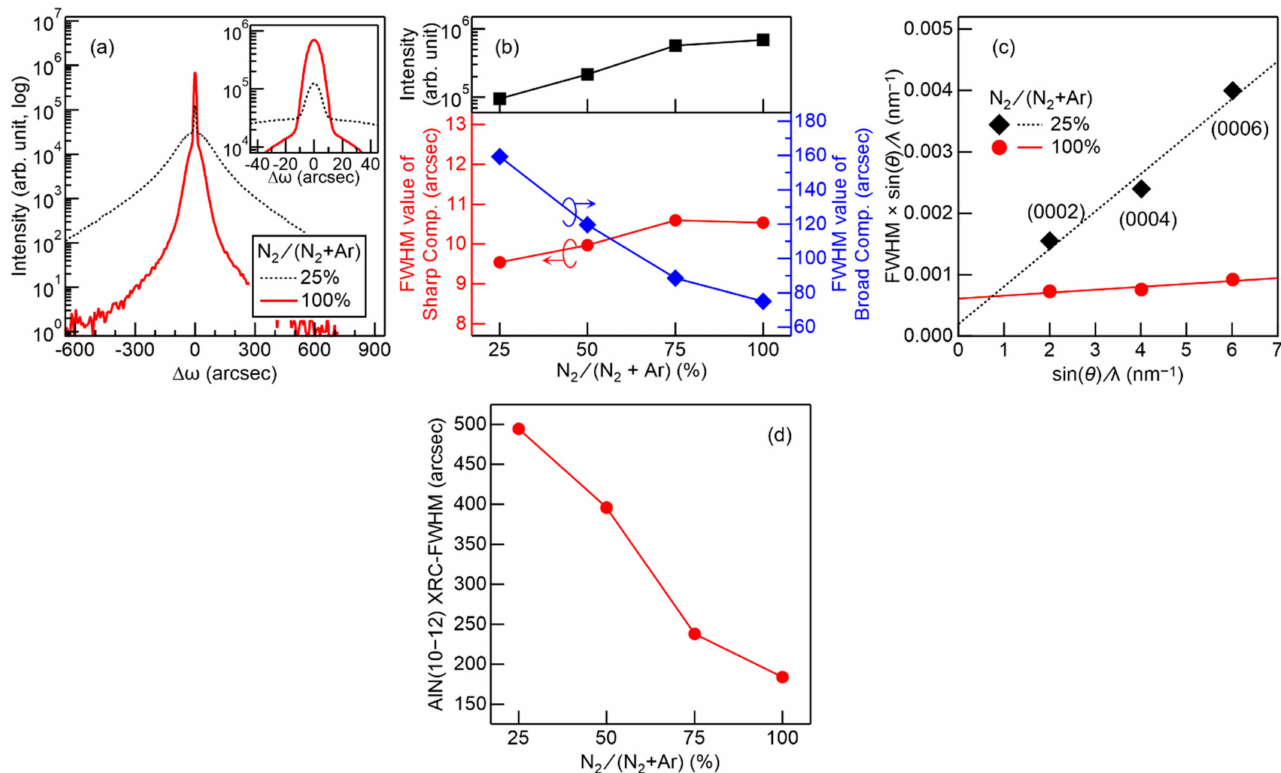
Figure 4. ( a ) High-resolution XRC profiles of AlN(0002) diffraction of the face-to-face annealed sputter-deposited AlN template (FFA Sp-AlN) that was deposited using N 2 /(N 2 + Ar) = 25% and 100%. The inset shows the enlarged profiles of the sharp component. ( b ) Effect of N 2 /(N 2 + Ar) ratio on the peak intensity of the sharp component and XRC-FWHM values of the sharp component and broad component of the AlN(0002) diffraction. ( c ) Williamson–Hall plot of the FFA Sp-AlN samples. The FWHM values of the broad component in the high-resolution XRC profiles were used for all the diffractions, as long as the sharp component was visible. If the XRC profiles only contain one component, the FWHM value is that of the entire profile. The lines are the linear fit. ( d ) Relationship between AlN(10 − 12) XRC-FWHM values of FFA Sp-AlN and the N 2 /(N 2 + Ar) ratio of the sputtering